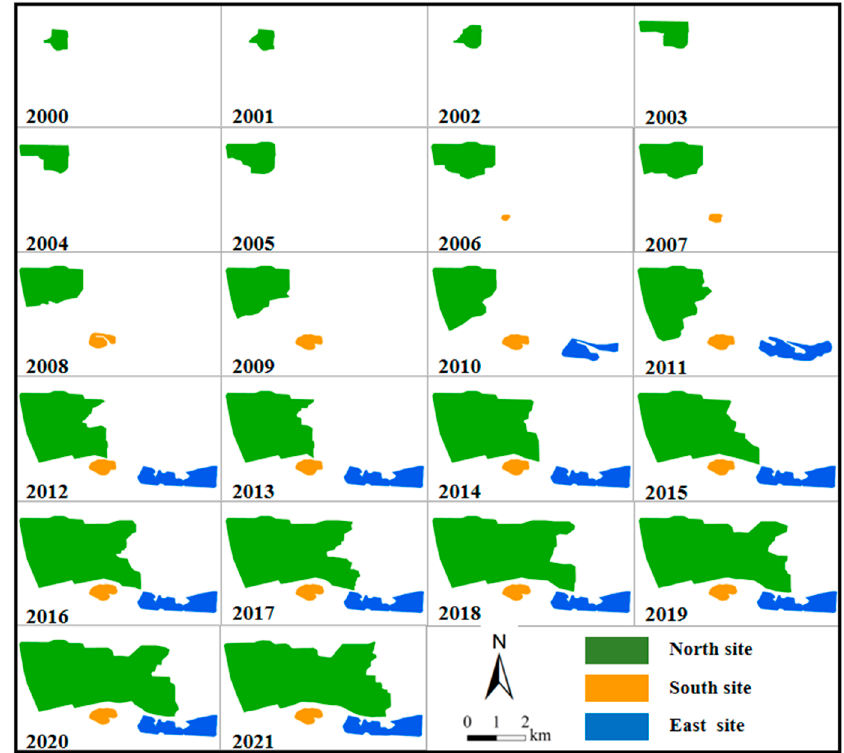
Figure 4. Results of the boundary extraction for the dumping sites from 2000 to 2021.